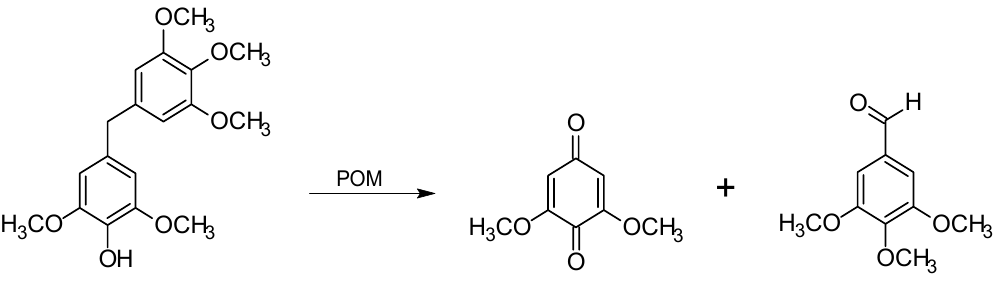
Figure 8. Degradation of a phenolic diphenylmethane with POMs